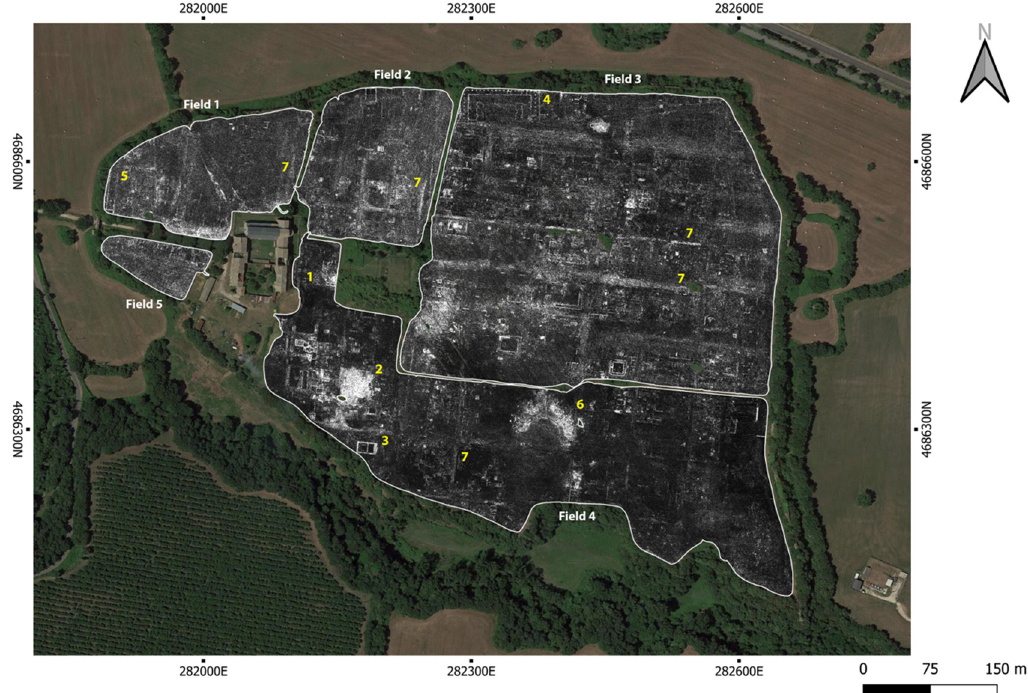
Figure 3. Falerii Novi, urban area. GPR time-slice between 14–15 ns of fields 1, 2, 3, 4, and 5. Numbers indicate: (1) the “ macellum ”; (2) bath complex; (3) temple; (4) porticus duplex ; (5) columned portico; (6) the theatre; (7) streets (time-slices from [28]; aerial photograph from Google Earth; image by M. Serpetti).